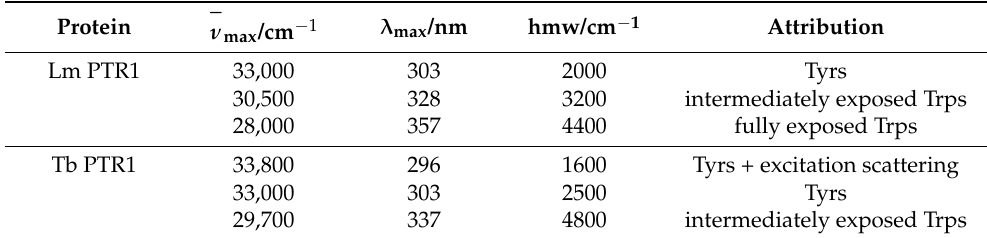
Table 1. Results of Gaussian band reconstructions of emission spectra of Lm and Tb PTR1: hmw = width at half maximum. Excitation at 280 nm.